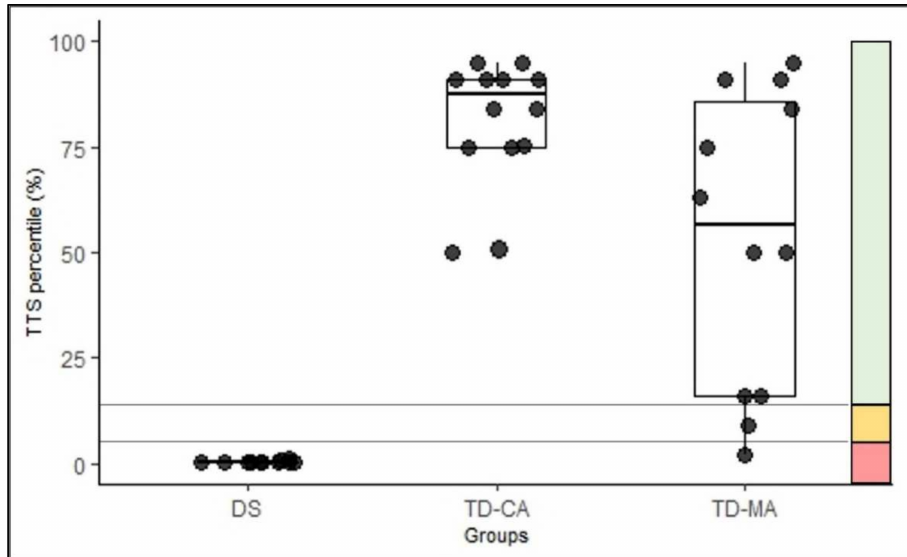
Figure 2. Classification of the total test score (TTS) percentiles of the groups in the traffic light system. Values ≤ 5th percentile: motor deficits (red zone); values between the 6th and 15th percentile: high-risk group (amber zone); values > 15th percentile: inconspicuous (green zone) [34]. Note: DS = Down Syndrome; TD-MA = Typically developing children of the same mental age; TD-CA = typically developing children of the same chronological